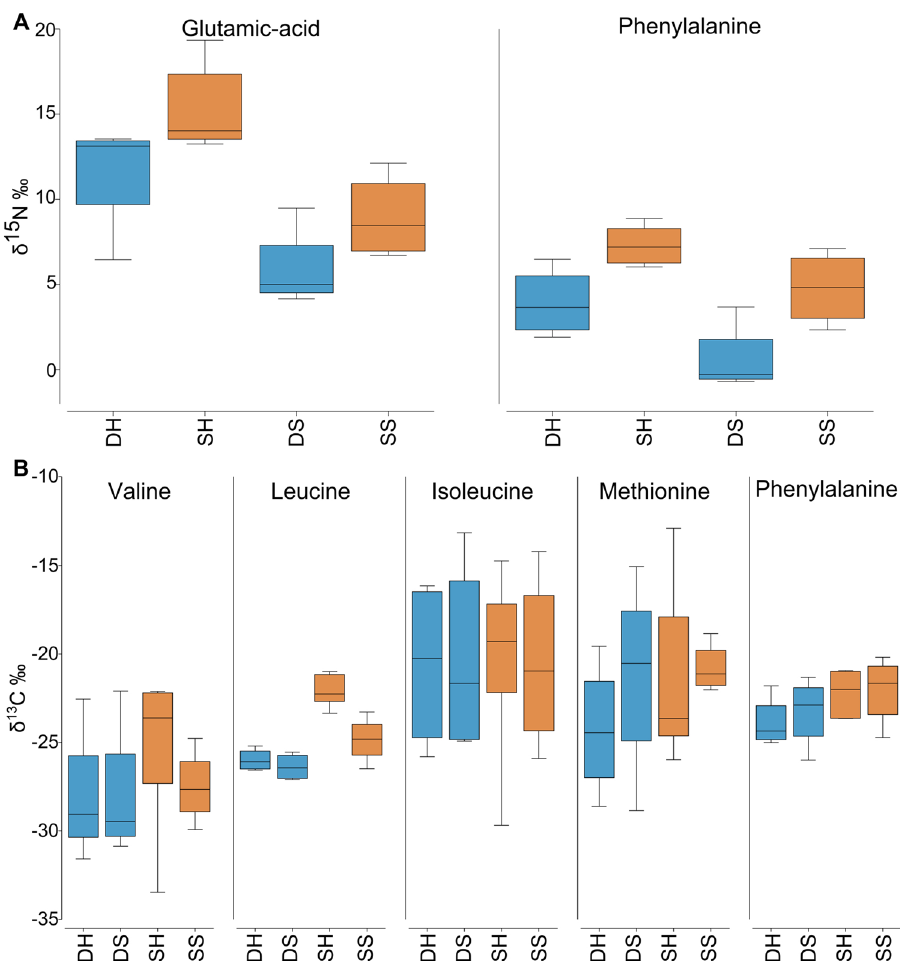
Figure 6. Amino acids isotopic value of Oculina patagonica from 30 m (’Deep’, blue) and 2 m (’Shallow’, red) water depth. Sample are DH (deep host), DS (deep symbiont), SH (shallow host) and SS (shallow symbiont). ( A ) Nitrogen isotopic value of two amino acids (glutamic-acid and phenylalanine) that are used for the calculation of the trophic position. ( B ) Carbon isotopic value of five essential amino acids (valine, leucine, isoleucine, methionine, and